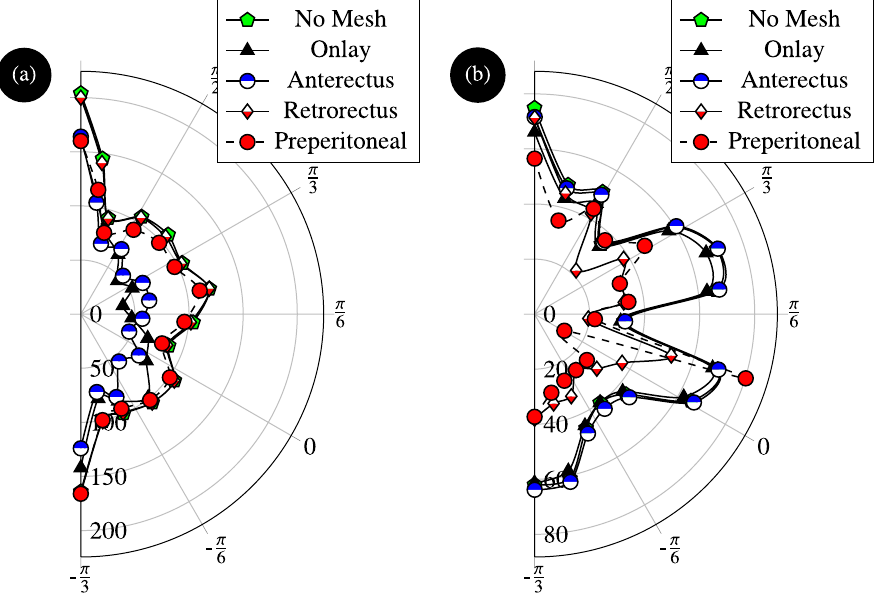
Figure 11. Distributions of equivalent stress (expressed in kPa) within the hernia damage zone around the ( a ) external and ( b ) internal interfaces of the linea albea with various mesh reinforcement positions .